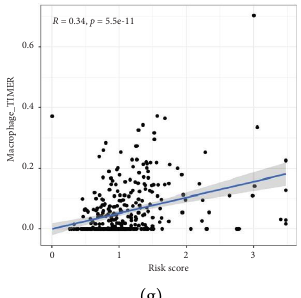
Figure 5: (a) Te correlation between multiple immune scores and risk score; (b) the correlation analysis between DC and risk score; (c) the correlation analysis between stromal score and risk score; (d) the correlation analysis between CD4 + Tcells and risk score; (e) the correlation analysis between cancer-associated fbroblasts and risk score; (f) the correlation analysis between hematopoietic stem cell and risk score; (g) the correlation analysis between macrophages and risk score.